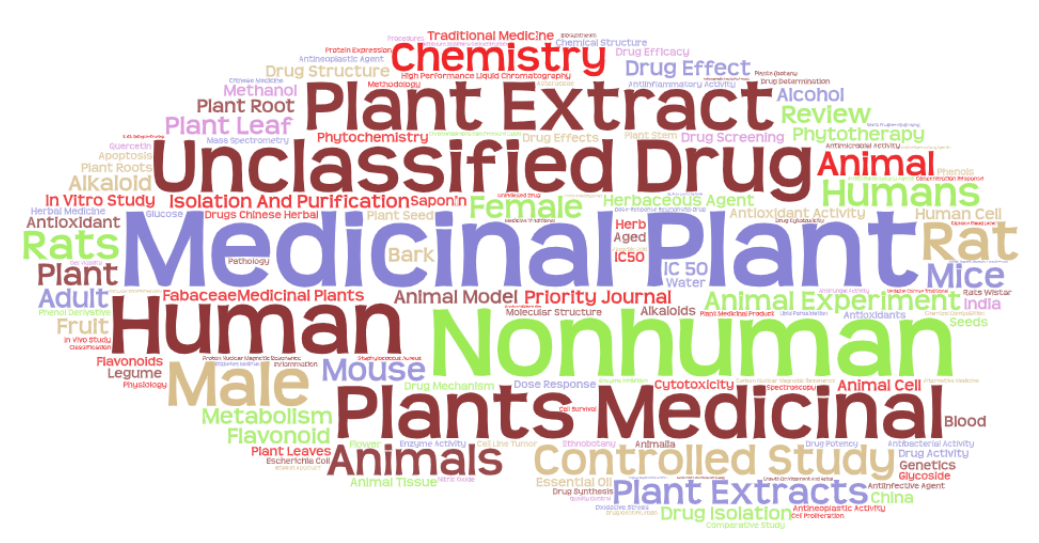
Figure 8. Cloudword of keywords in medical plants publications.